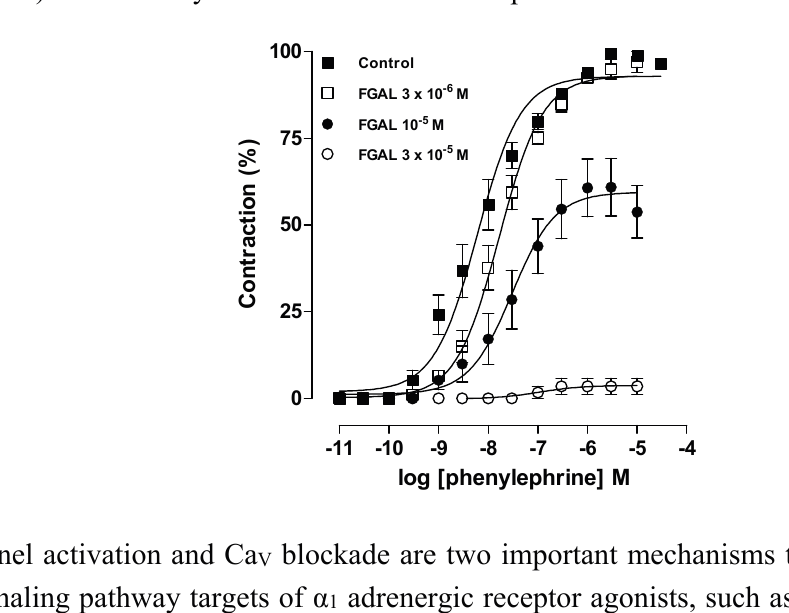
Figure 3. Cumulative concentration-response curves to phenylephrine in both the absence ( ■ , control, n = 5) and presence of 3 × 10 − 6 ( □ , n = 3), 10 − 5 ( ● , n = 3) and 3 × 10 − 5 M ( ○ , n = 3) of FGAL. Symbols and vertical bars represent the mean and S.E.M.,